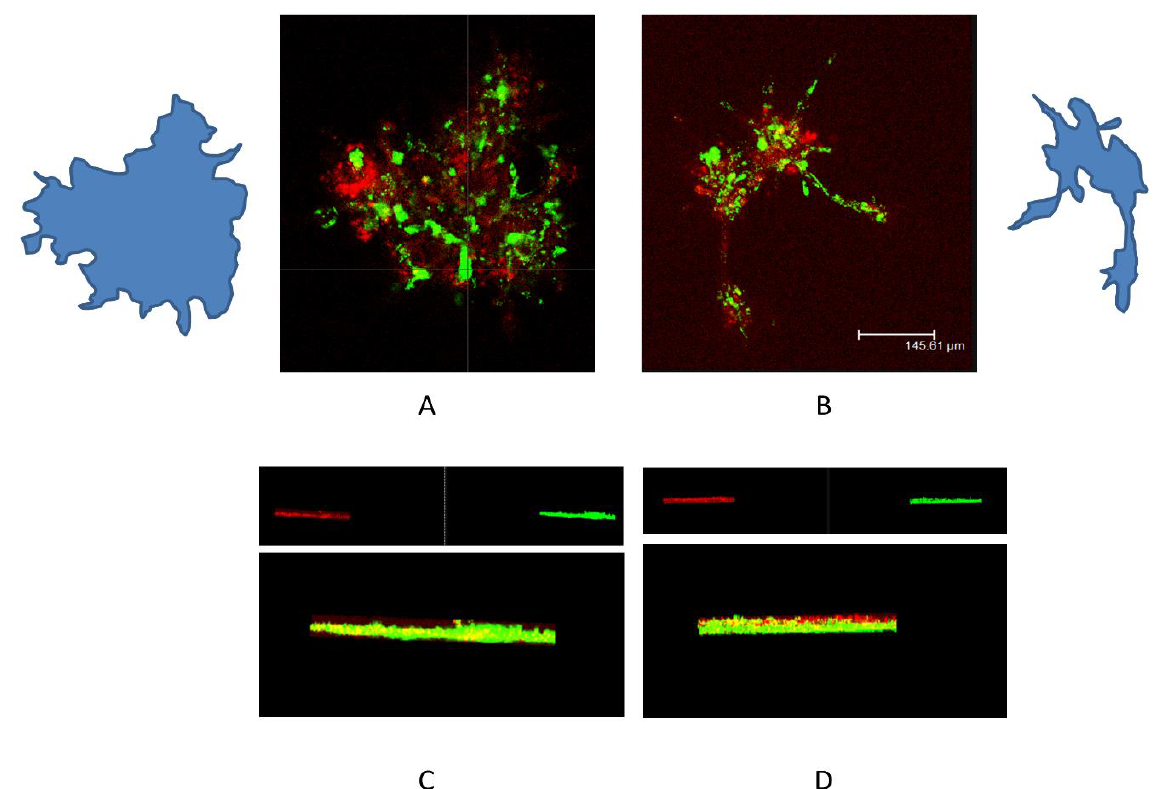
Figure 12. Representative confocal images of fibroblast (green) and keratinocytes (red) co-cultured on Matrigel in normal gravitational ( A ) and microgravity conditions ( B ) for 24 h. ( C , D ) show the three-dimensional Leica software reconstructions. The confocal microscope analysis showed that in OG, the fibroblasts were arranged randomly with keratinocytes, while in the RPM, the fibroblasts and keratinocytes had distinct positions (scale bar 145.6 µm).